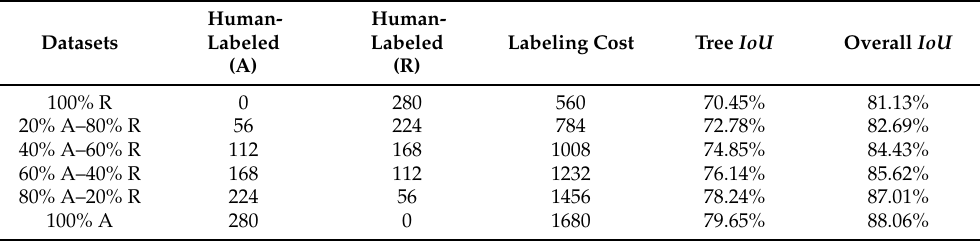
Figure 8. Classification results on two test images. In each test image, subplots from left to right then top to bottom represent false color images (near IR1, red, and green), ground truth and classification results from models trained by different proportions of two quality levels of masks (100%R, 20%A, 40%A, 60%A, 80%A and 100%A). Table 4. Labeling cost and accuracy comparison among datasets with different proportions of two quality levels of masks (A: accurately delineated mask; R: roughly delineated